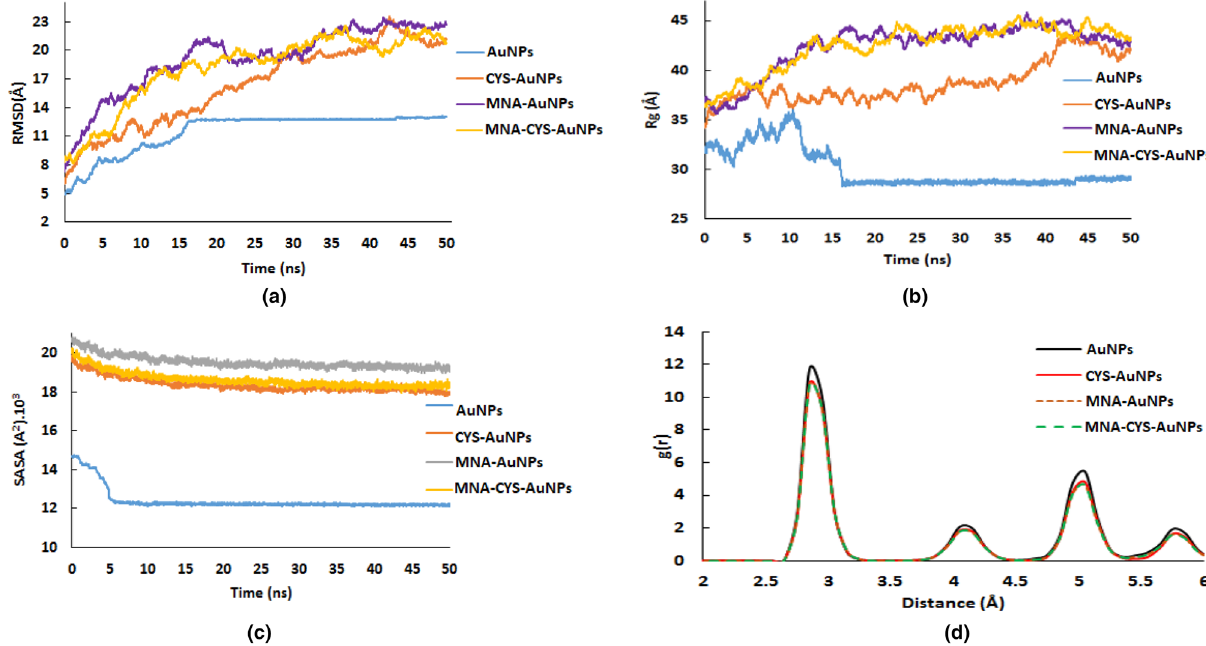
Figure 2. The calculated RMSD ( a ), Rg ( b ), and SASA ( c ) of the pure and functionalized AuNPs during the simulation time and RDF plot ( d ) of the Au–Au pair of the corresponding